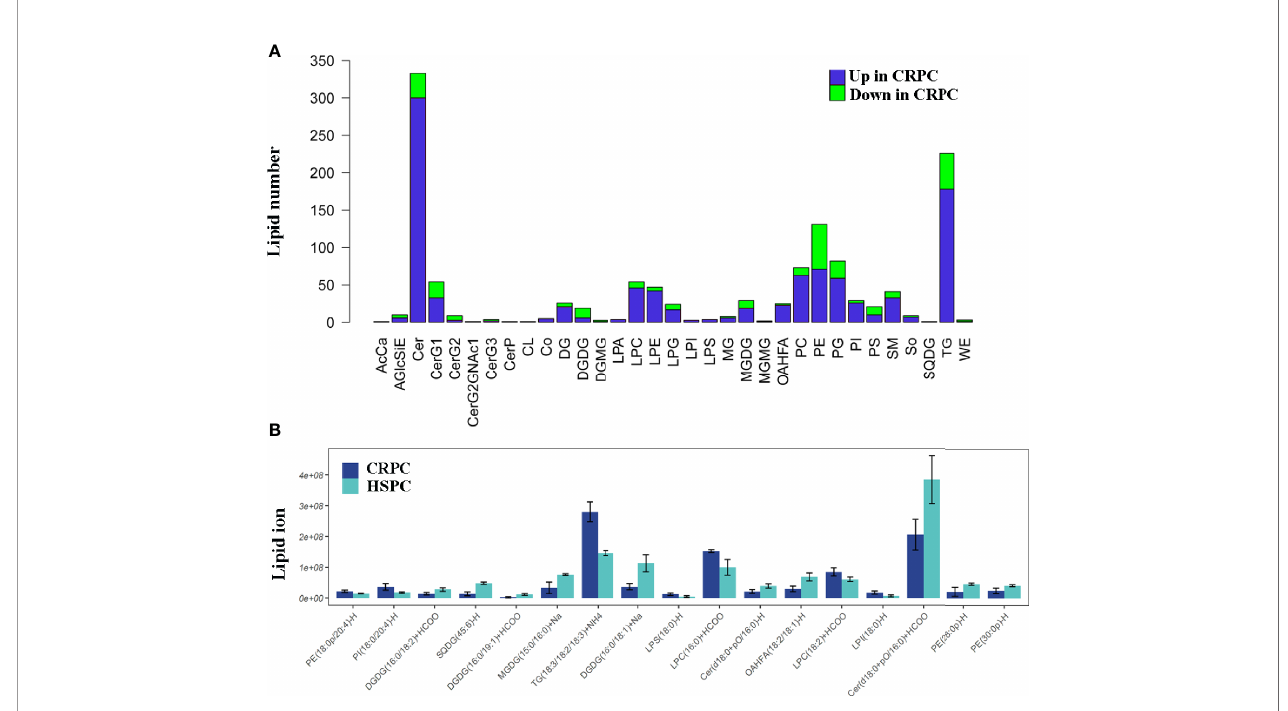
FIGURE 5 | Fecal lipid pro fi les of mice after FMT. (A) Lipidomics showed that the levels of most lipid classes including glycerophospholipids were increased in mice after FMT with CRPC feces. The blue bars indicated the number of lipids within each lipid class that increased in CRPC FMT treated mice., while the greed bars indicated the number of lipids that decreased. (B) On the species level, 17 species were signi fi cantly different between the two groups, 16:0 LPC and 18:2 LPC were signi fi cantly increased in CRPC FMT treated mice.